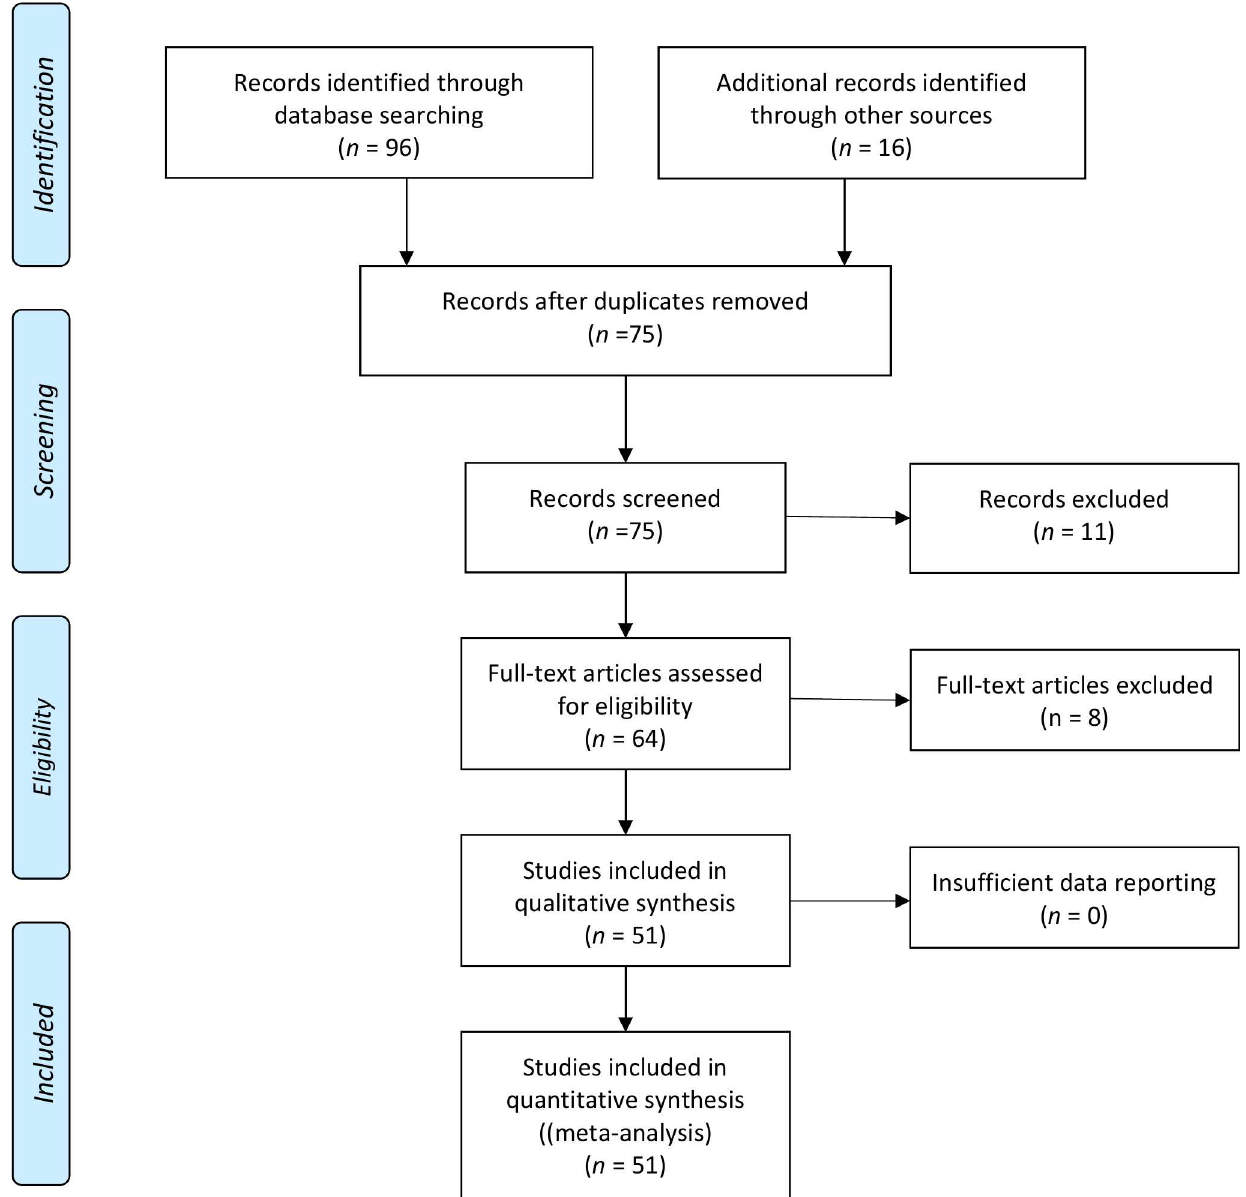
Fig 1. PRISMA flow of information through the different phases of the